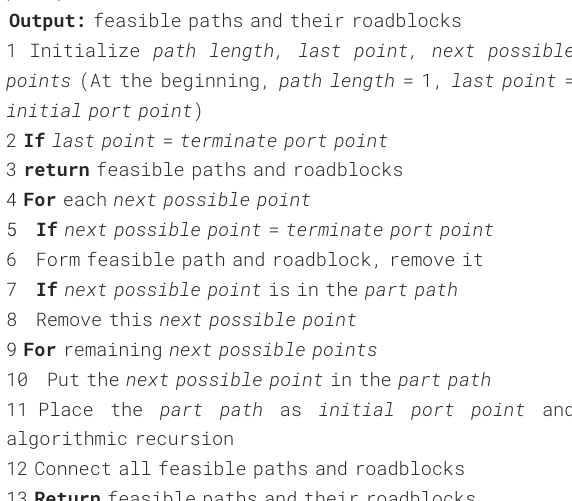
Algorithm 1: Depth- fi rst fi nd-path